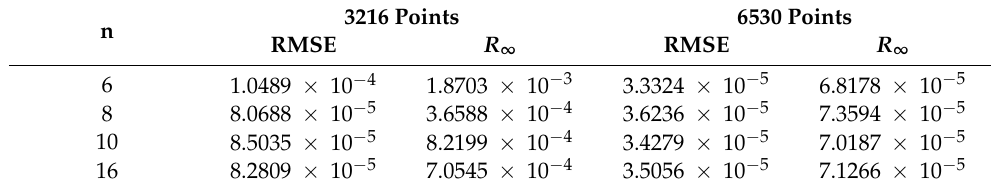
Table 5. Example No. 2—comparison of RMSE and R ∞ for a different number of virtual points.